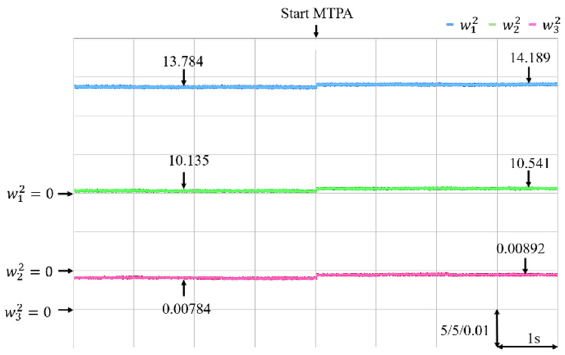
Figure 13. Variations of connected weights of PID neural network of d -axis current loop from without MTPA control to with MTPA control at 1000 rpm with 4.75 Nm.